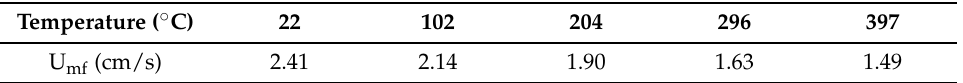
Table 5. Minimum fluidization velocity vs.